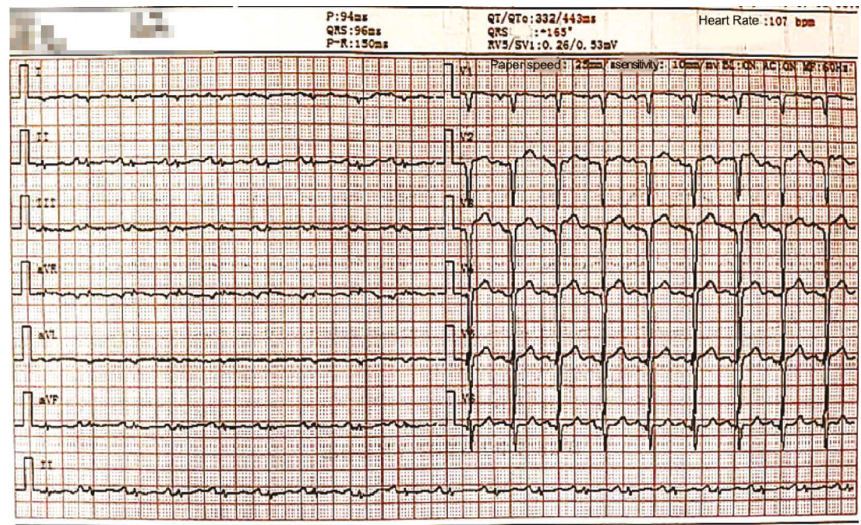
Figure 3: ECG photos of the proband.